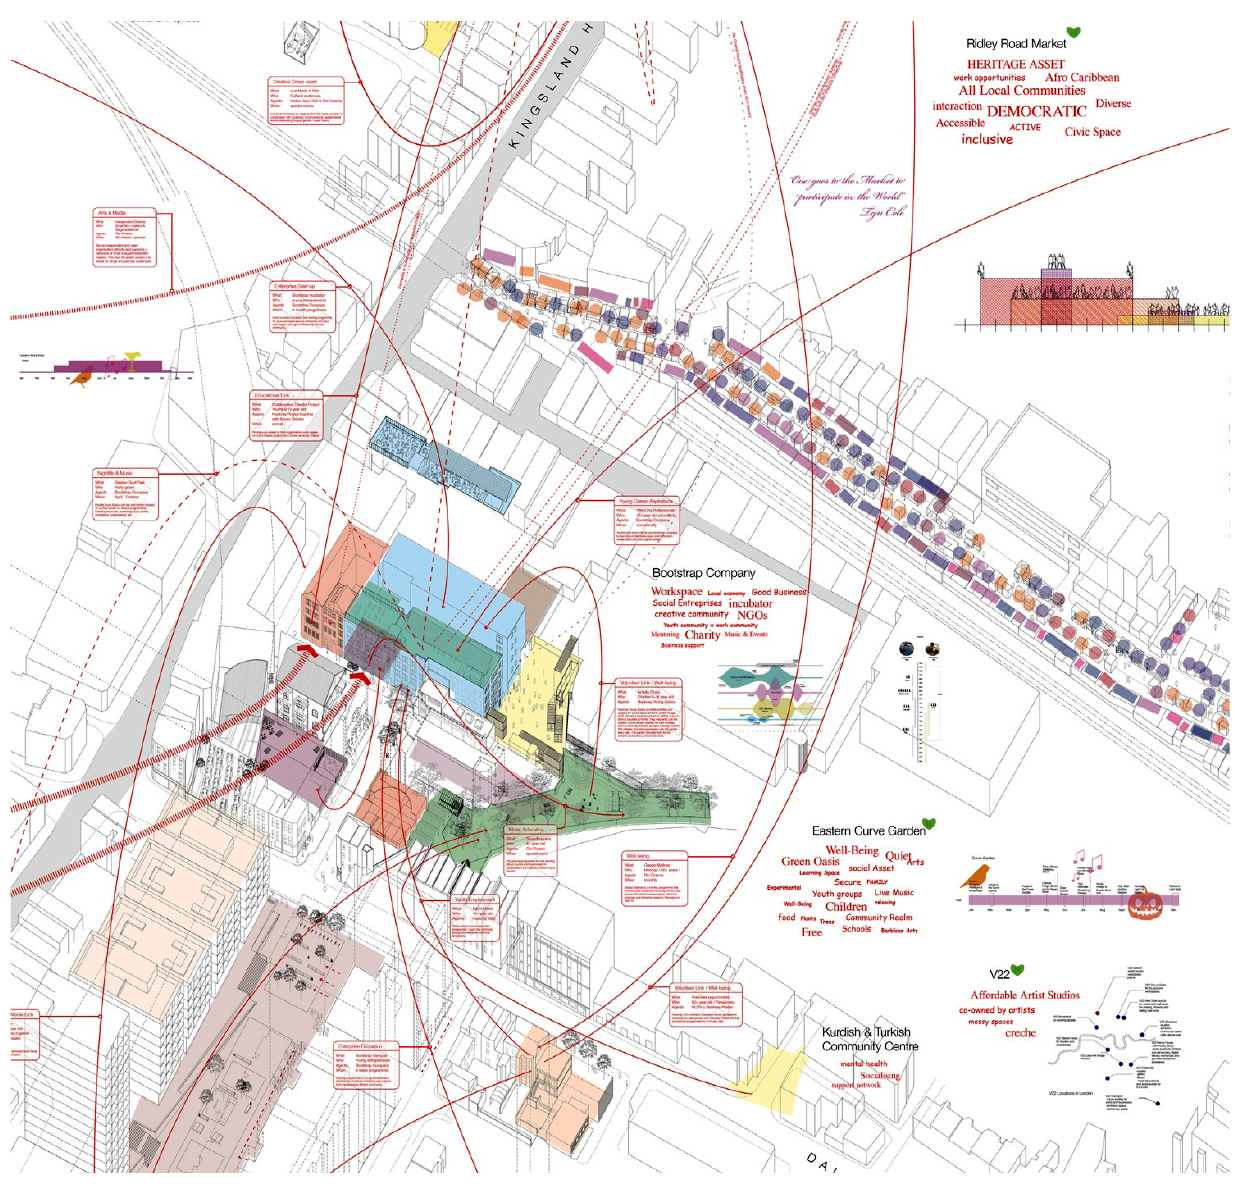
Figure 4. Extract from RSD map with stakeholder Bootstrap Charity’s relations and activities across the Dalston Quarter using “tag‐clouds” and Ridley Road Market that was found to have a significant status and which became subject to further research during 2019. Source: Courtesy of Unit A research